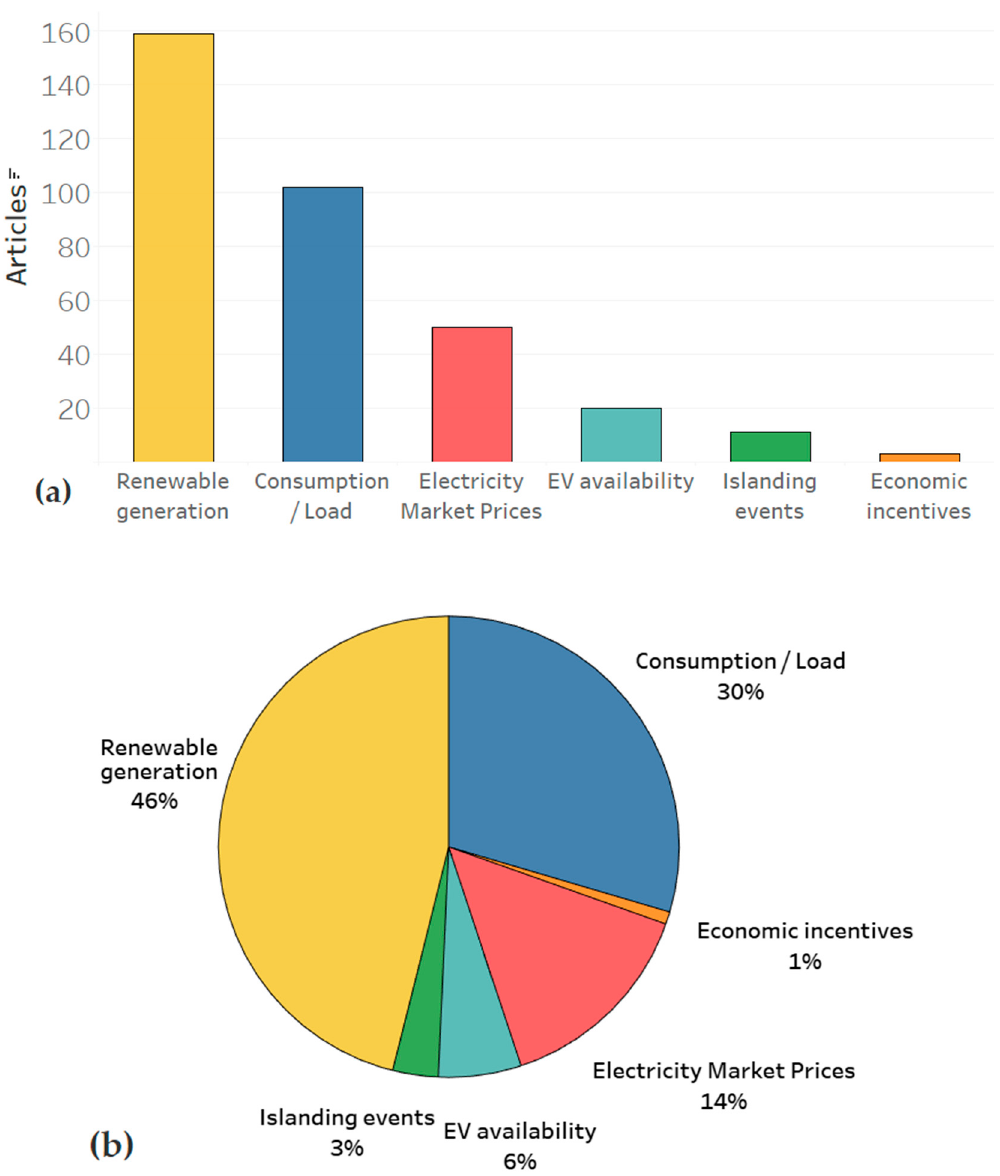
Figure 3. ( a ) Number of articles that consider each SoU. ( b ) Share of each SoU in the total number of SoUs analyzed in the pool of articles. Note: each article may consider more than one SoU. Self- elaboration.